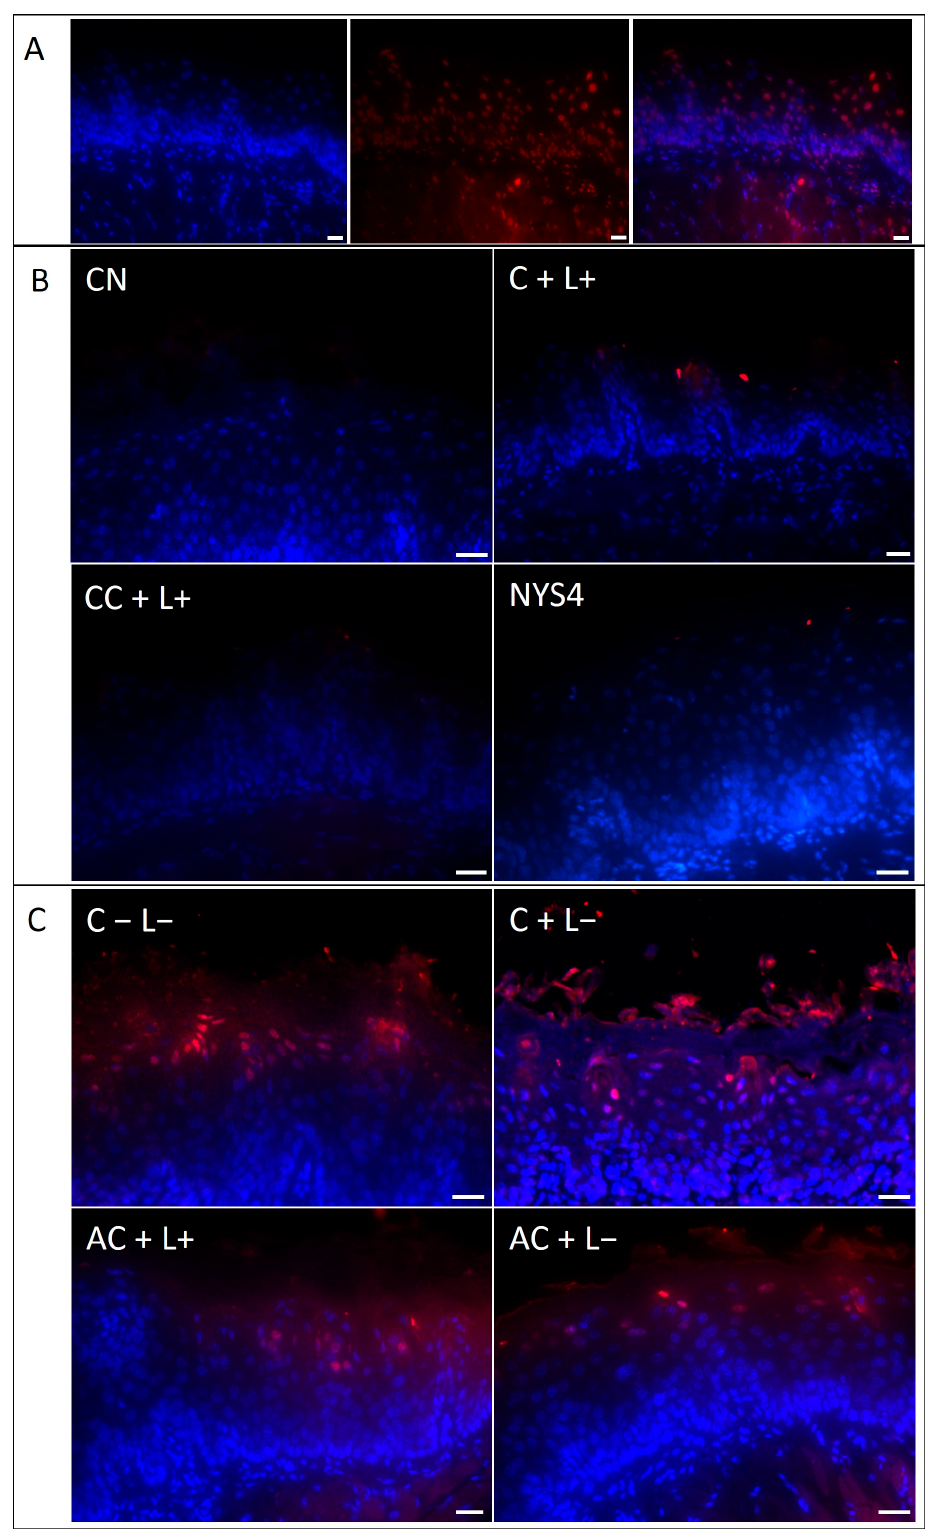
Figure 11. TUNEL assay of sections from the tongue of mice. ( A ) Positive control of the reaction (DNAse-treated sample) showing blue channel, red channel and overlay from left to right. ( B ) These